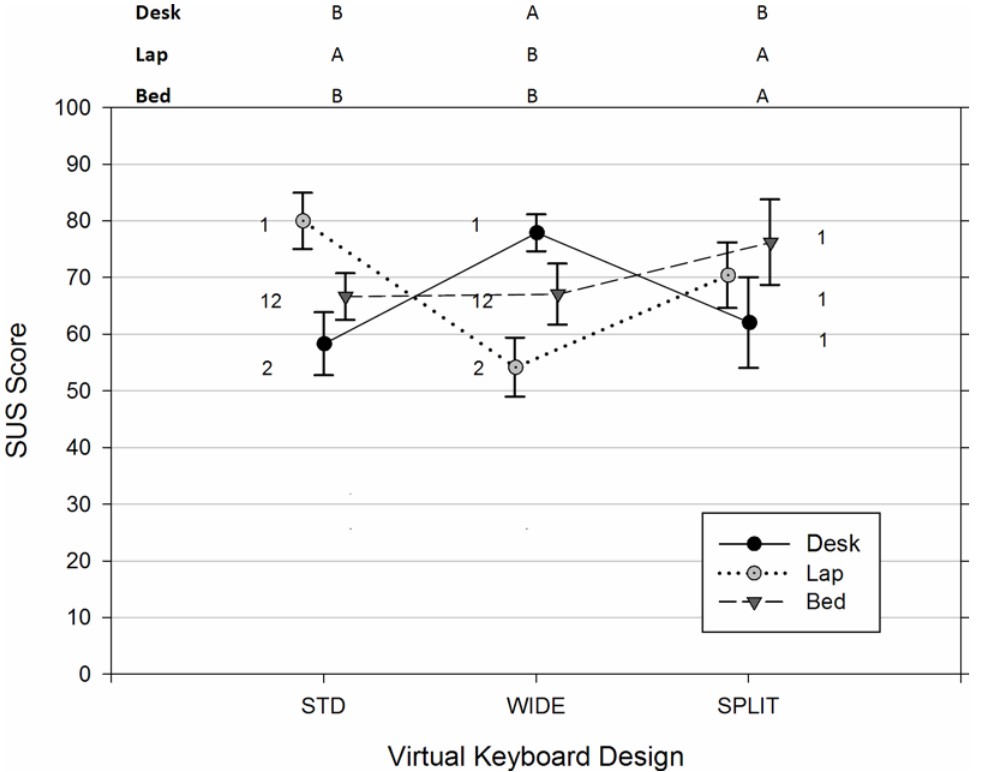
Fig 8. Mean perceived usability of virtual keyboard designs varied across different positions of tablet usage. Conditions with the same number (1, 2, 3) denote groups without significant difference across the usage positions within the same virtual keyboard design. Conditions with the same character (A, B, C) denote groups without significant difference across the keyboard designs within the same usage